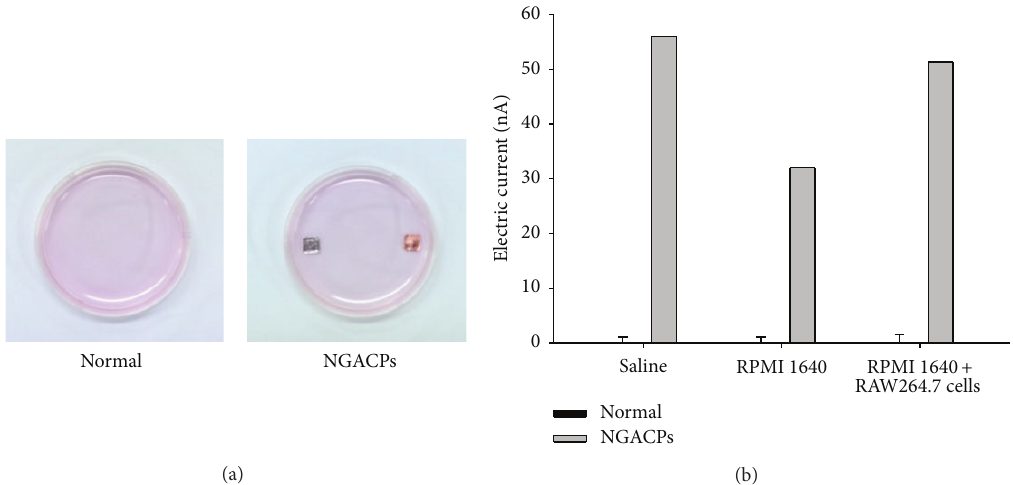
Figure 1: Current induction levels of aluminum-copper patch (ACP) in cell-plated medium. (a) Photos of ACPs were taken with a digital camera. (b) The electrical field was measured using a multimeter as described in Section